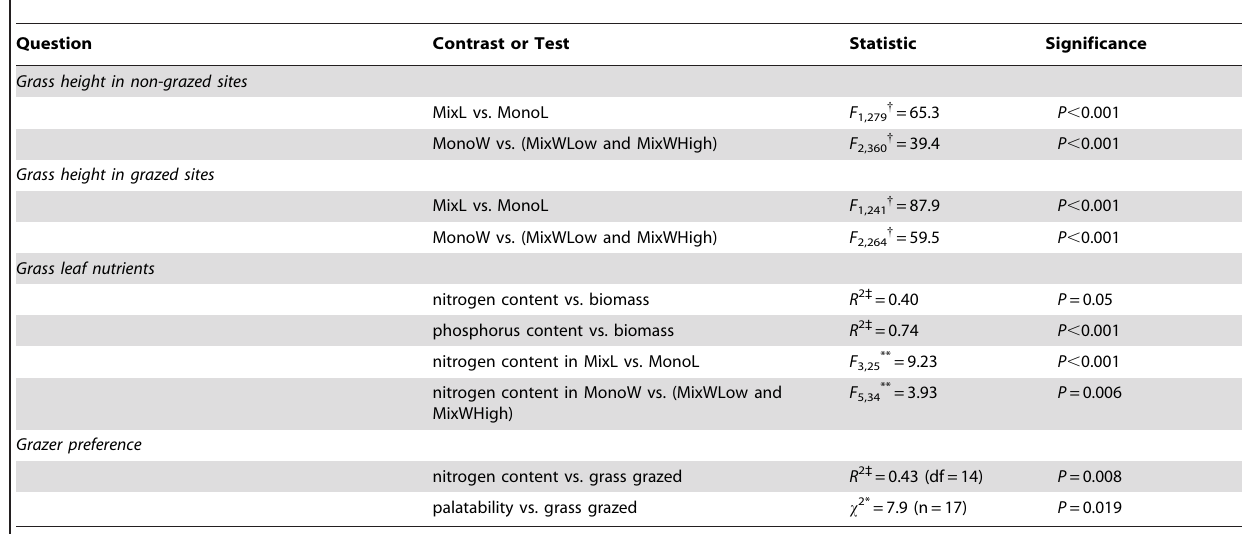
Table 2. Comparisons conducted and their statistical values addressing the various questions (see Table 1 for abbreviations).